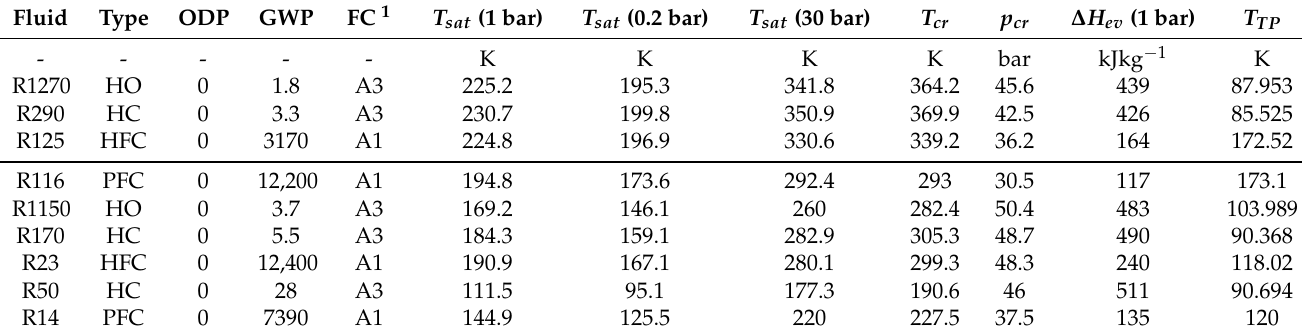
Table 1. Thermodynamic data of the refrigerants considered [43].